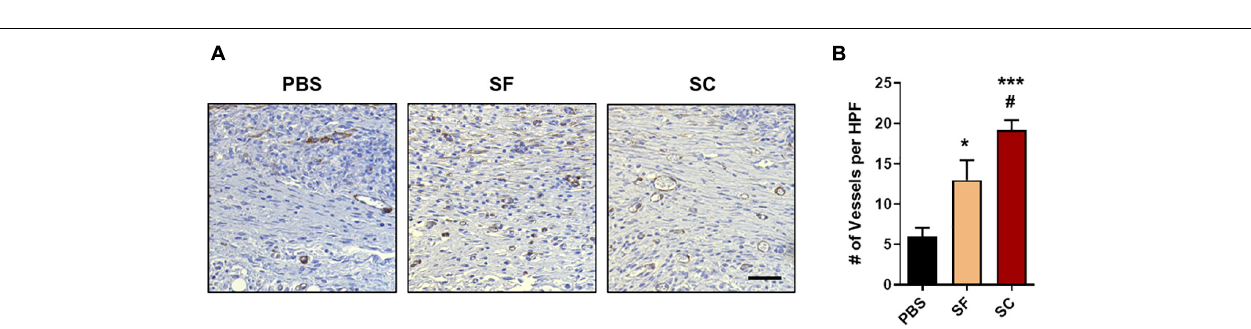
FIGURE 5 | Masson’s trichrome (MTC) staining of the wounds at day 21. (A) Representative light microscopy images (Scale bar = 100 µ m). The qualitative analysis of the skin regeneration (B) collagen deposition, (C) extracellular matrix (ECM) fiber alignment, and (D) the number of skin appendages (*compared with the PBS group; # compared with the SF group; ∗ p < 0.05; ** p < 0.01; *** p < 0.001).